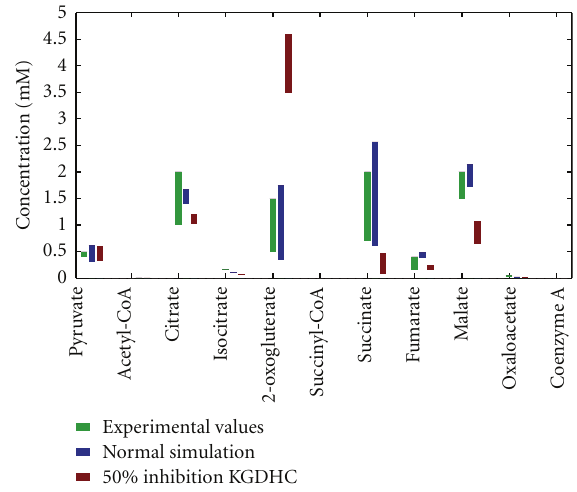
Figure 3: Comparison of simulated and experimentally determined concentrations of TCAC intermediates. Green bars indicate the concentration range of reported experimental values [21–29]. Blue bars (normal state) and red bars (50% inhibition of KGDHC) indicate variations of concentration when varying the energetic load between 33% and 100% of maximum. in the membrane potential, hinting to metabolic failure. The mitochondrial redox potential (expressed through the NADH/NAD ratio) showed a quasilinear decline from 0.3 to 0.1 for ATP consumption rates up to the 2.5-fold